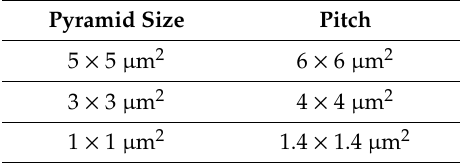
Table 1. Size and Pitch of the Manufactured